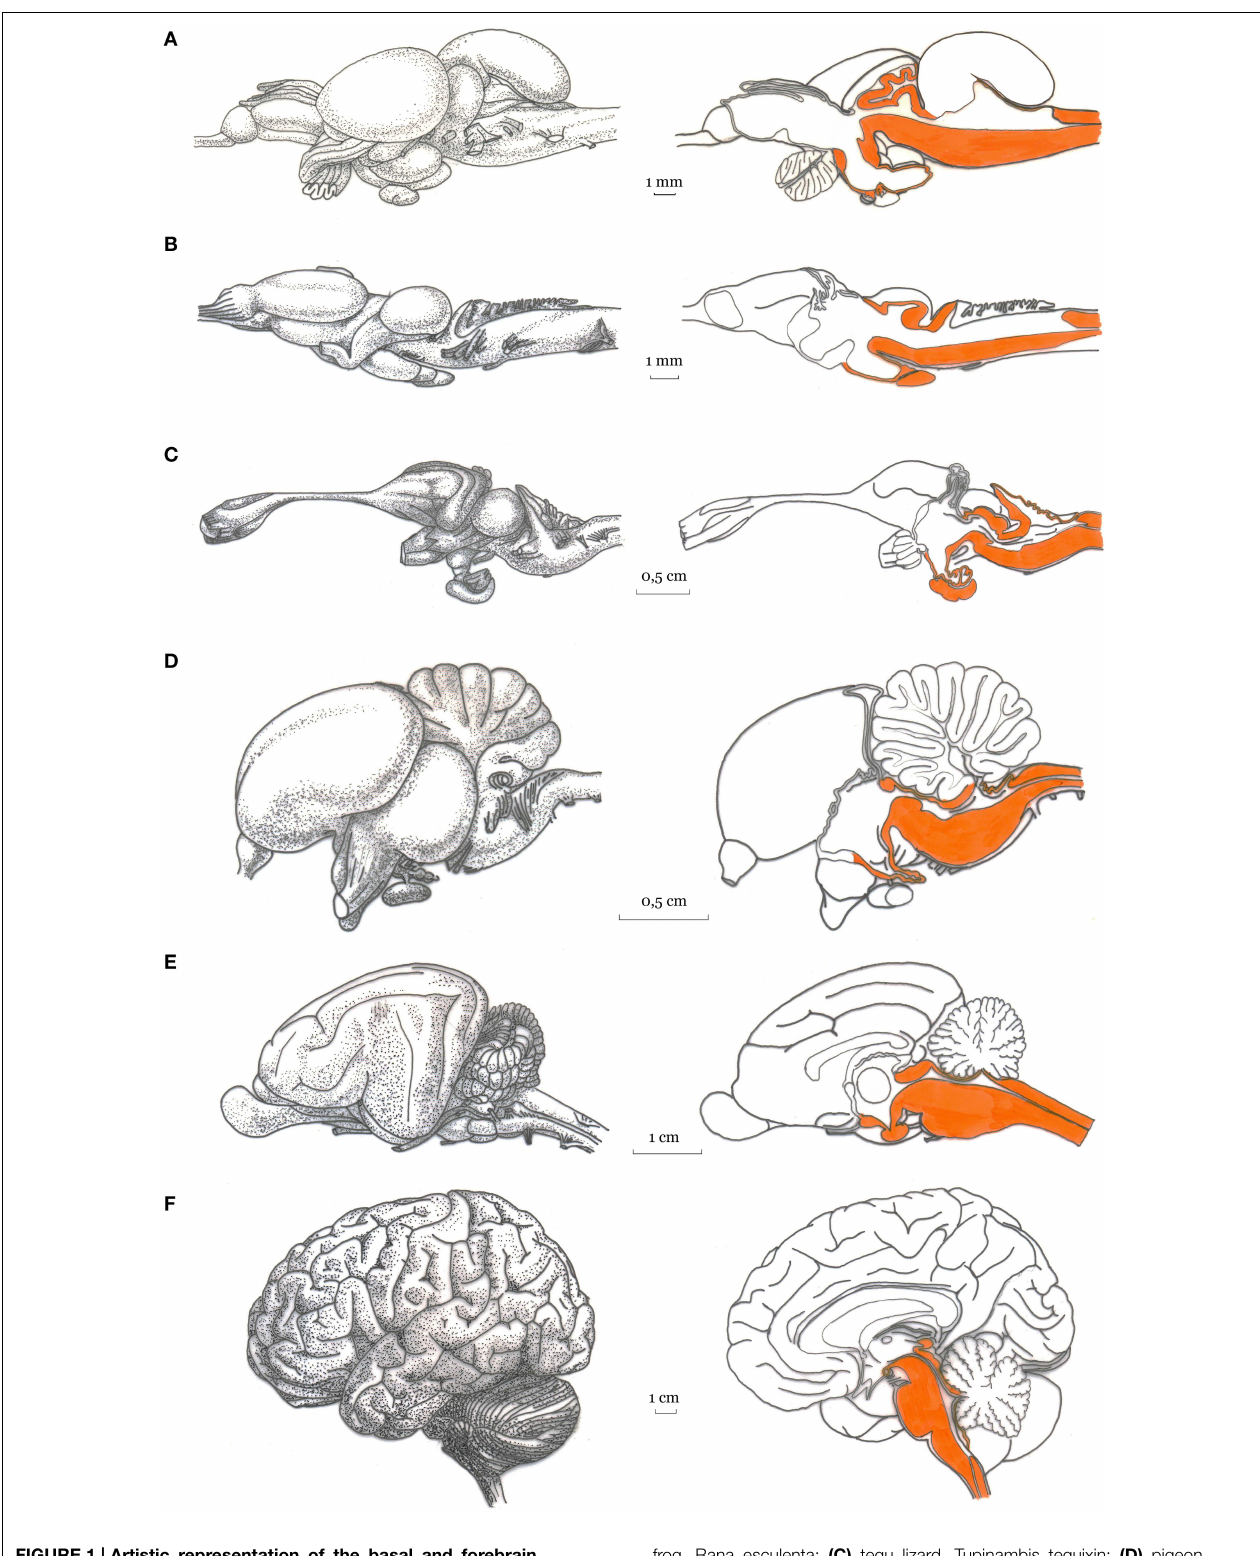
frog, Rana esculenta; (C) tegu lizard, Tupinambis teguixin; (D) pigeon, Columba livia; (E) cat; and (F) human brain. For each vertebrate brain, the basal subcortical regions is highlighted (in orange) in the mid-sagittal views.